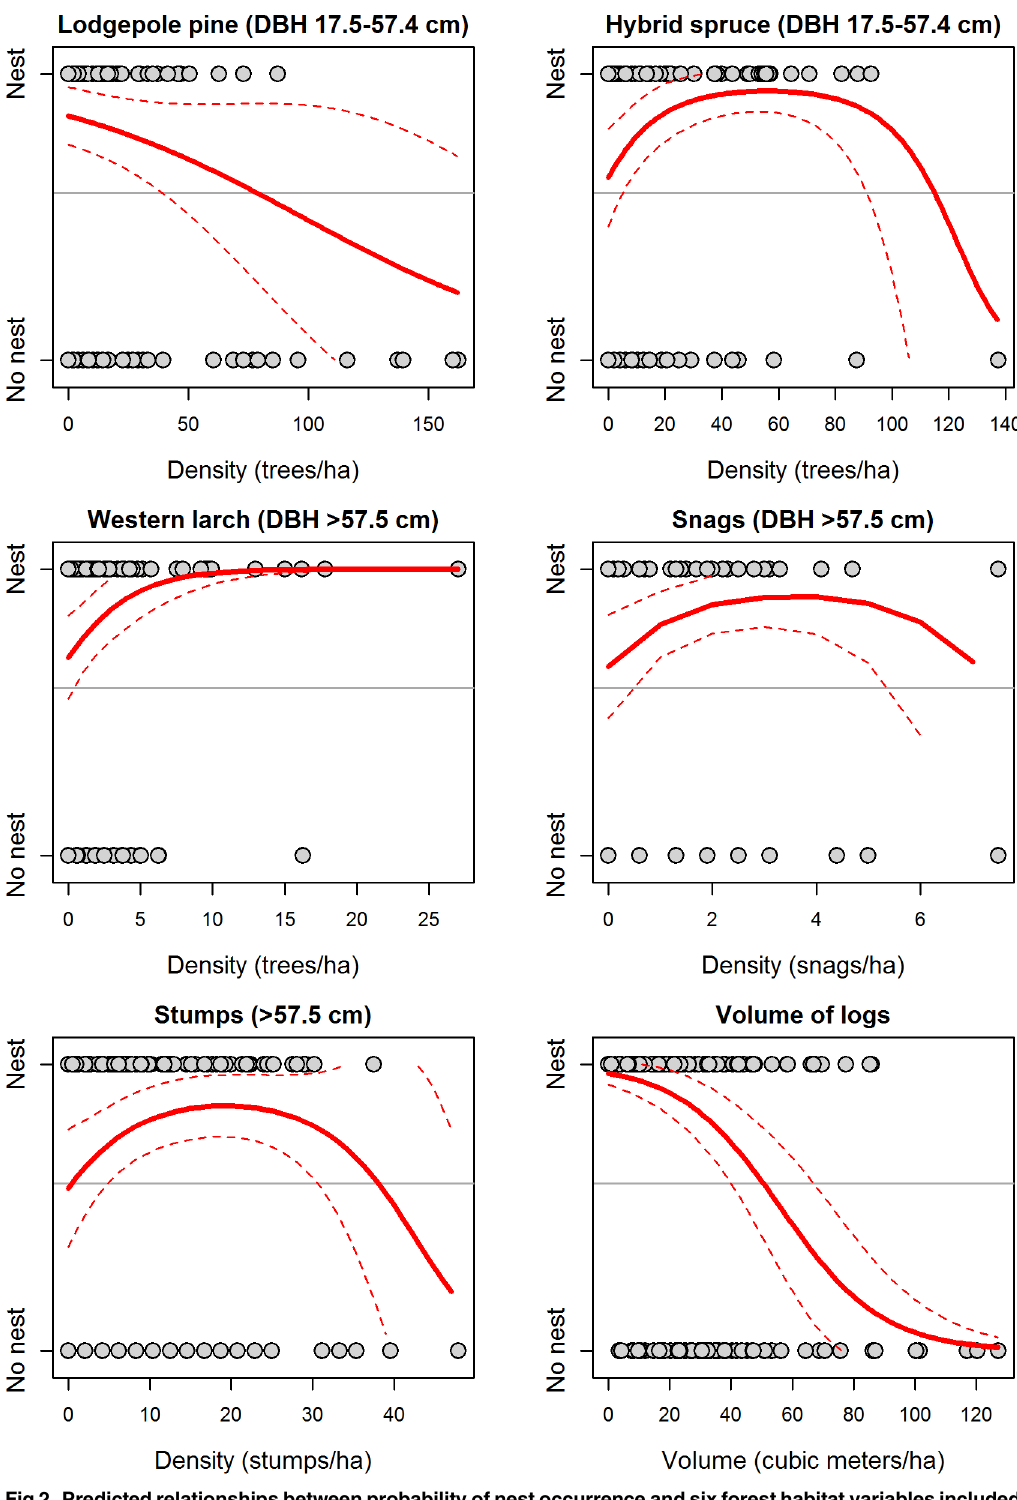
Fig 2. Predicted relationships between probability of nest occurrence and six forest habitat variables included in the Field225 model (21 variables originally considered) for the Okanagan-East Kootenay Region of the Williamson ’ s sapsucker Area of Occupancy in British Columbia, 2006 – 2008. Grey points depict nest occurrence ( ‘ Nest ’ ) or a random point ( ‘ No nest ’ ), and the title of each plot indicates the habitat variable. Solid lines indicate predicted values and thin dashed lines represent the 95% prediction interval. Horizontal line depicts proportion of points that were nests (i.e., the baseline probability of response variable having a value of